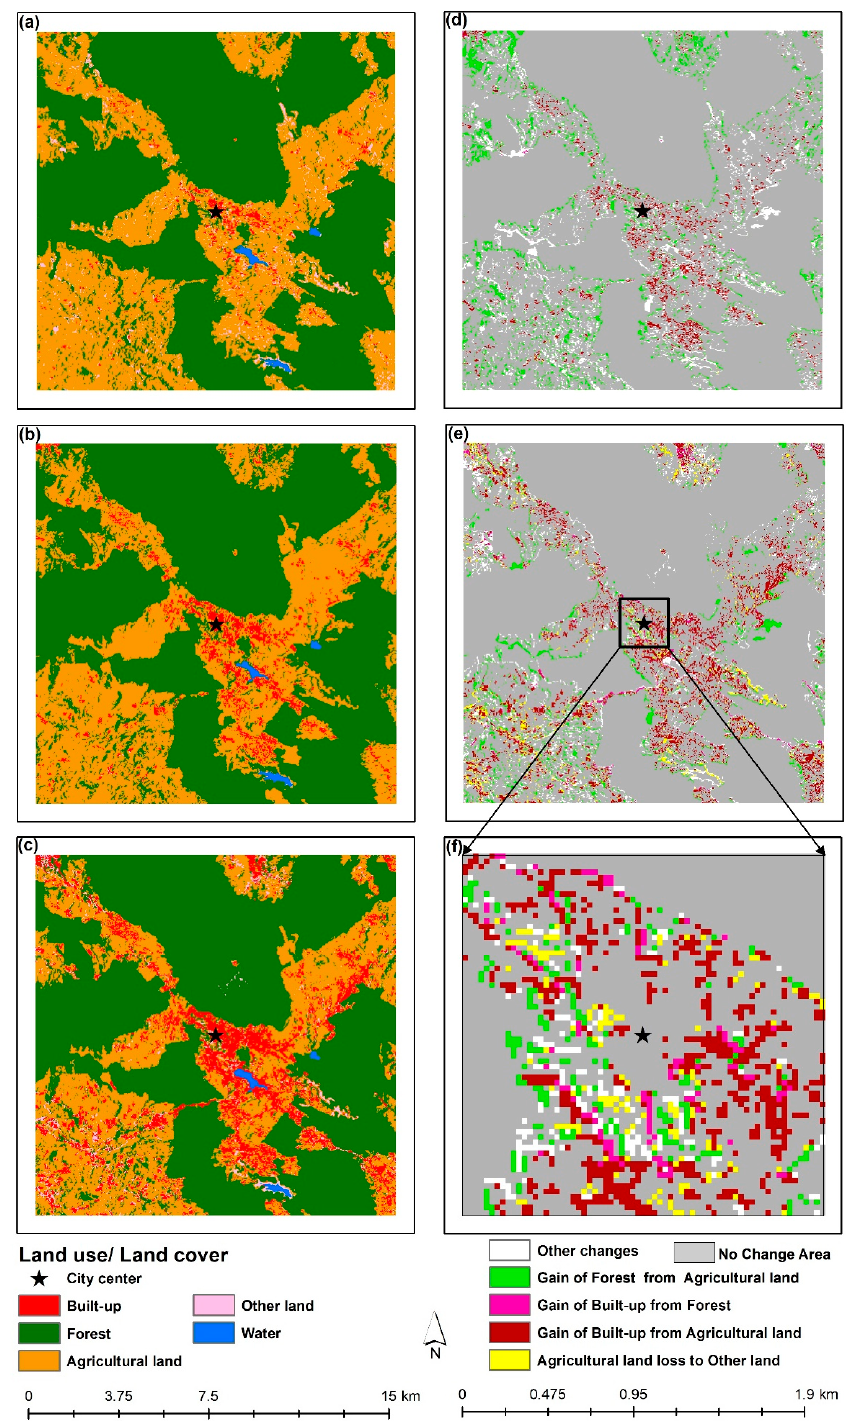
Figure 4. Land use and land cover changes in the Nuwara Eliya area: ( a ) Land use and land cover (LULC) in 1996; ( b ) LULC in 2006; ( c ) LULC in 2017; ( d ) LULC change from 1996 to 2006; ( e ) LULC change from 2006 to 2017; and ( f ) Zoom view of LULC change from 2006 to 2017 map.